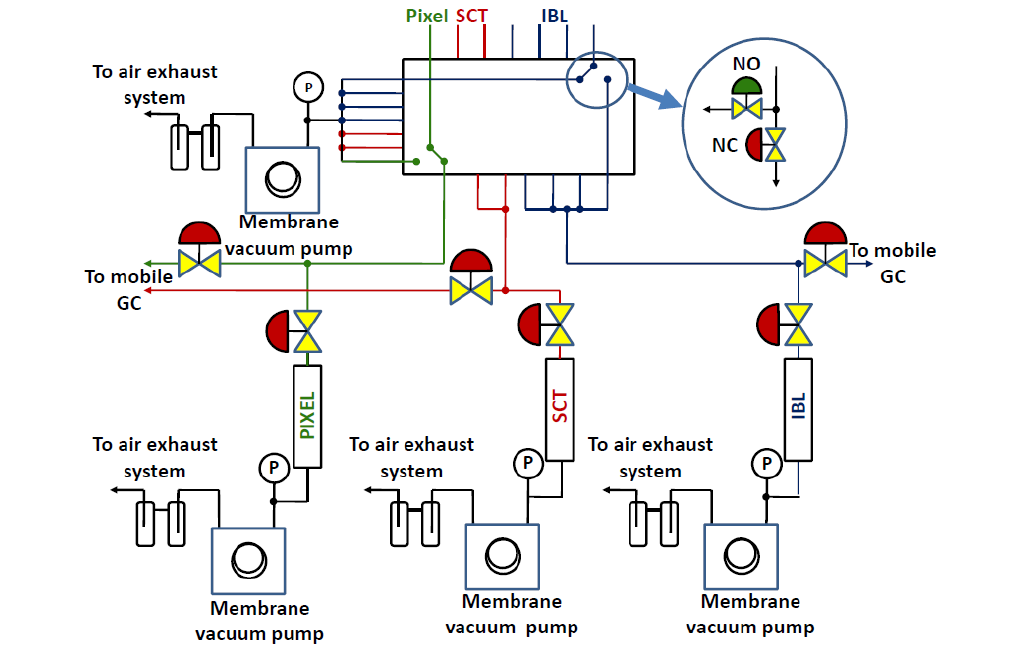
Figure 5. Schematic of the ATLAS inner detector leak detection system. Two ultrasonic analyzer tubes target detection of C Pixel and SCT detectors. A third tube targets CO A portable gas chromatograph (GC) can be connected as a calibration check or if more than one contaminating gas is suspected